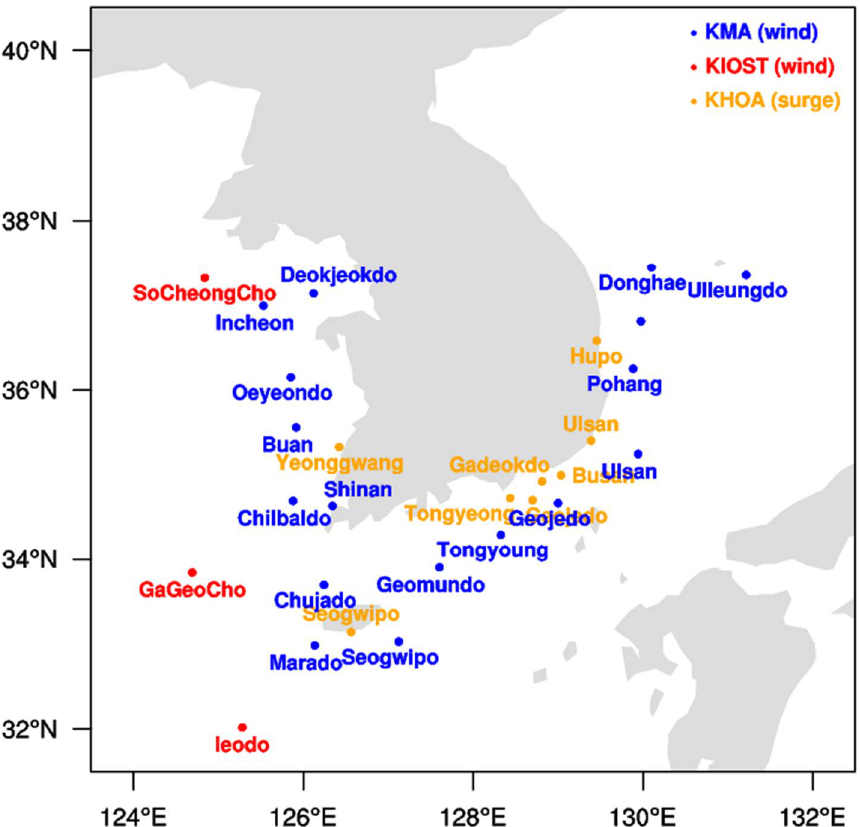
Figure 2. Observation locations of the KMA, KIOST, and KHOA from 2018 to 2022. The wind speed was observed in the KMA buoys (blue) and KIOST research stations (red). Orange dots indicate the KHOA surge height observation